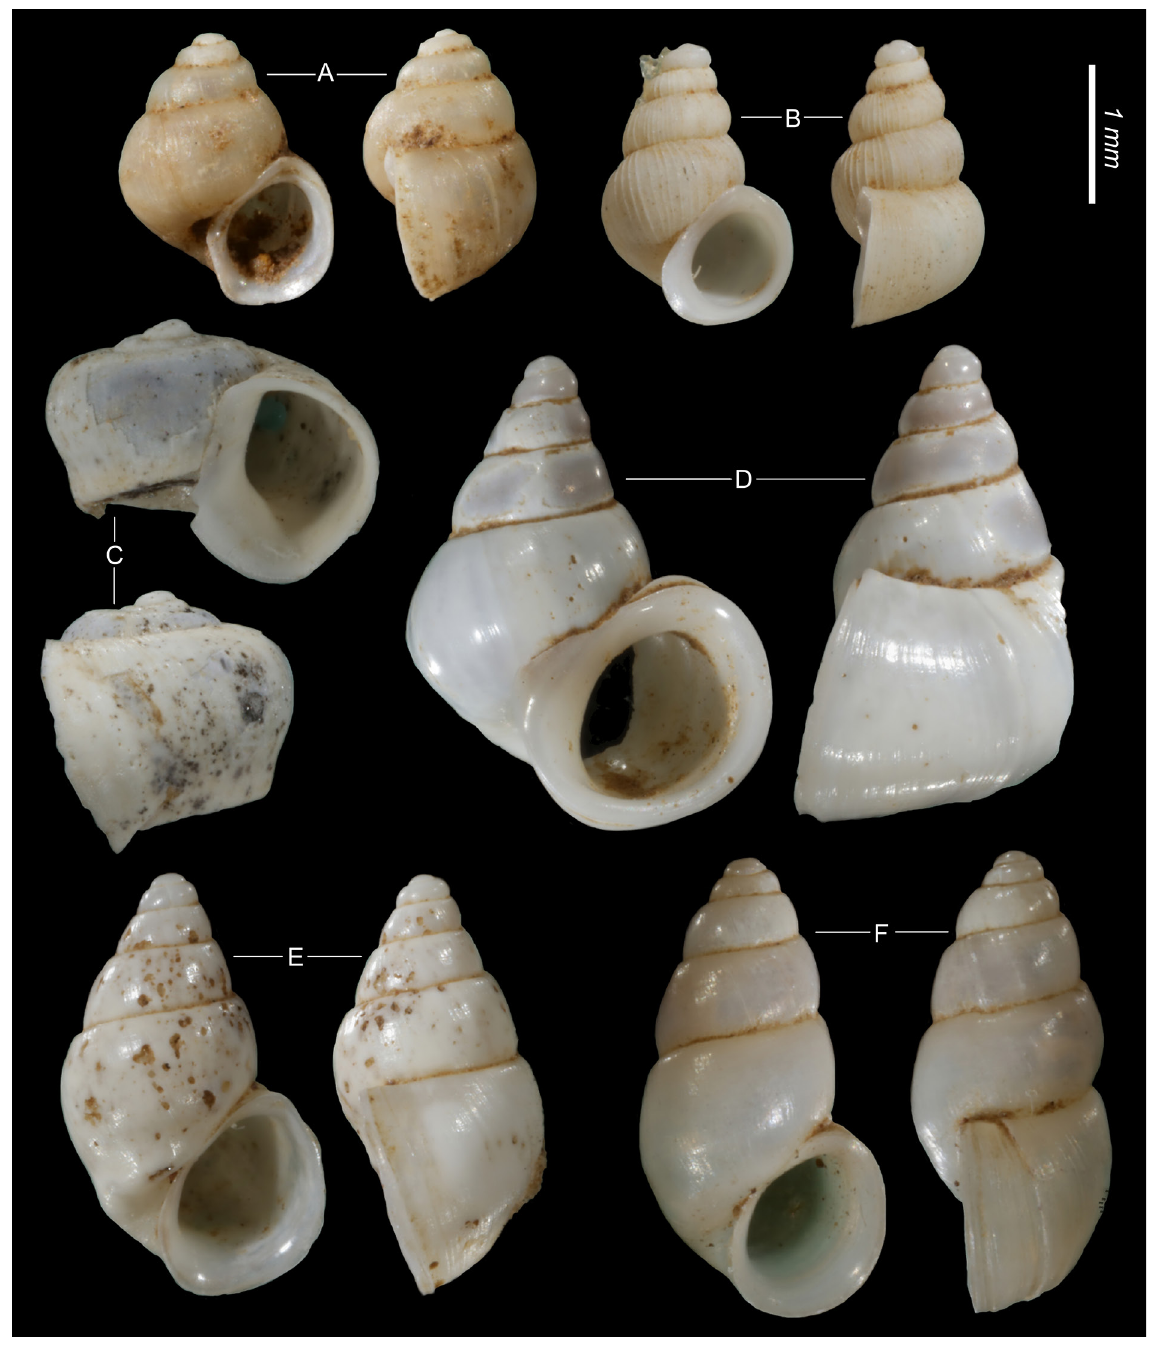
Fig. 13. Historical type specimens of species of Plagigeyeria from Hercegovina and adjacent regions, currently transferred to the genus Travunijana Grego & Glöer, 2019. A . Plagigeyeria robusta Schütt, 1959, Hercegovina, spring Čepelica near Bileća, holotype (SMF 162833). B . P. klemmi Schütt, 1961, Croatia, spring Stenjevac south of Vrgorac, holotype (SMF 164344). C . P. tribunicae Schütt, 1963, Hercegovina, spring Trebišnjica near Bileća, holotype (SMF 168968). D . P. edlaueri Schütt, 1961, Hercegovina, spring Sopot Mlin in Svitavsko Blato, holotype (SMF 164342). E . P. angelovi Schütt, 1972, Croatia, spring Ombla (Rijeka Dubrovačka) in Komolac, holotype (SMF 221242). F . P. nitida Schütt, 1963, Hercegovina, spring Sopot Mlin in Svitavsko Blato, holotype (SMF